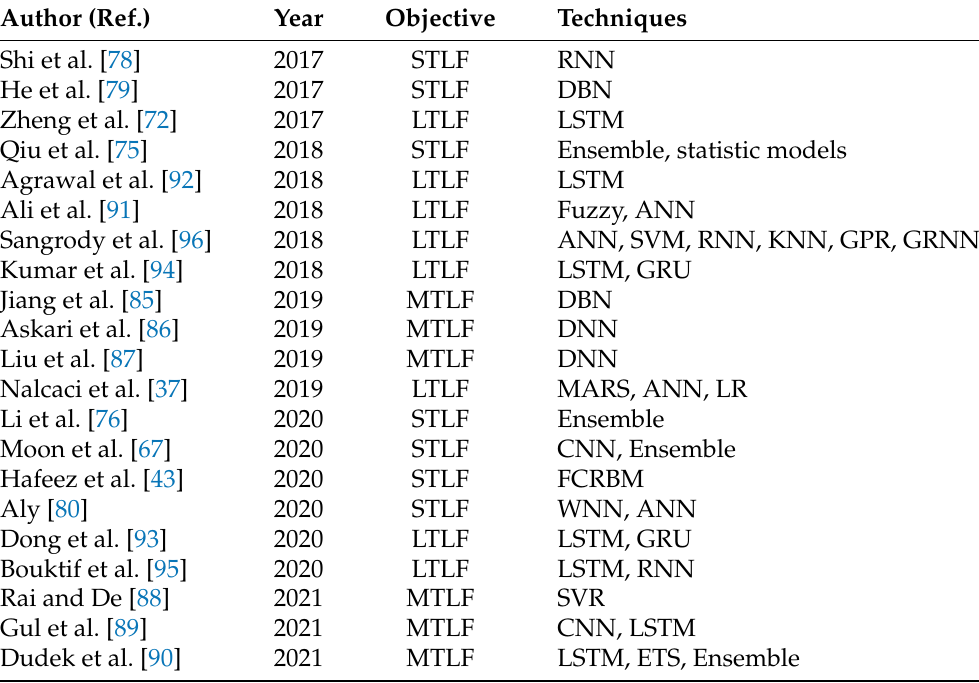
Table 1. Summary of approaches for